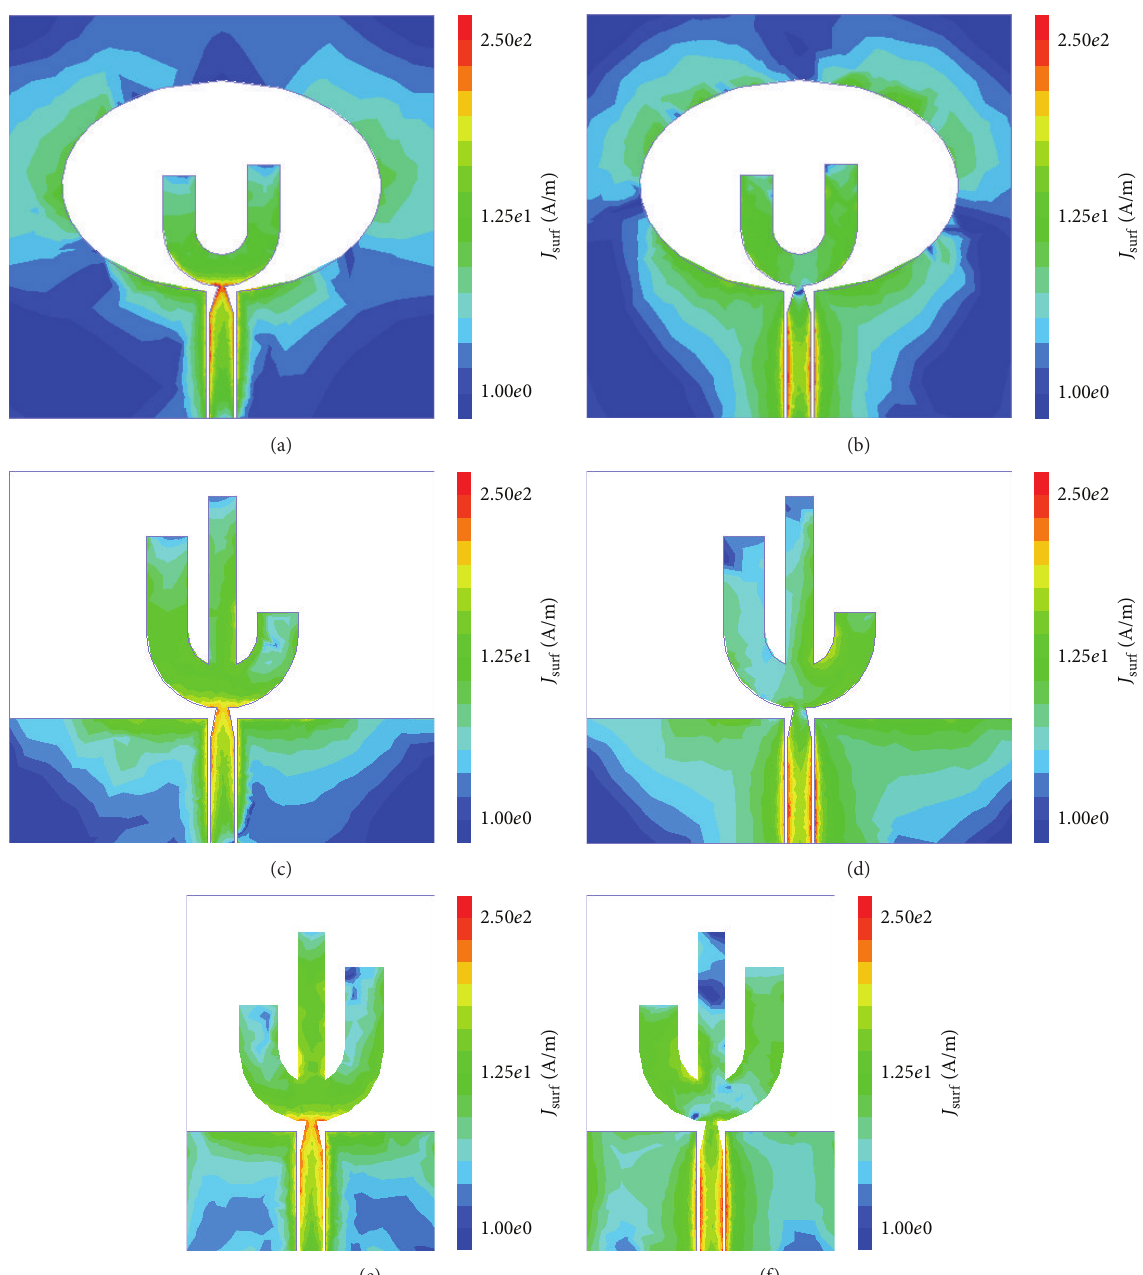
Figure 4: Surface current ( 𝐽 ) distributions on CPW-fed slot antenna at (a) 5GHz and (b) 9 GHz, cactus antenna at (c) 5GHz and (d) 9 GHz, and miniaturized cactus antenna at (e) 5GHz and (f) 9